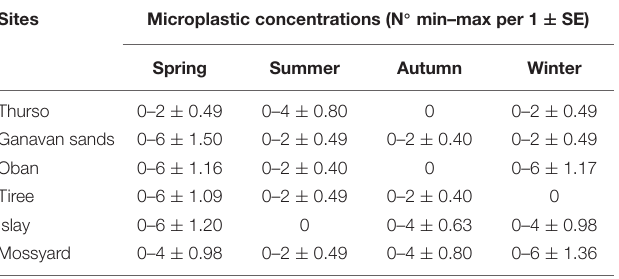
TABLE 2 | Minimum and maximum of microplastic concentrations in seawater (number of particles per l) with the standard errors for each site and season.